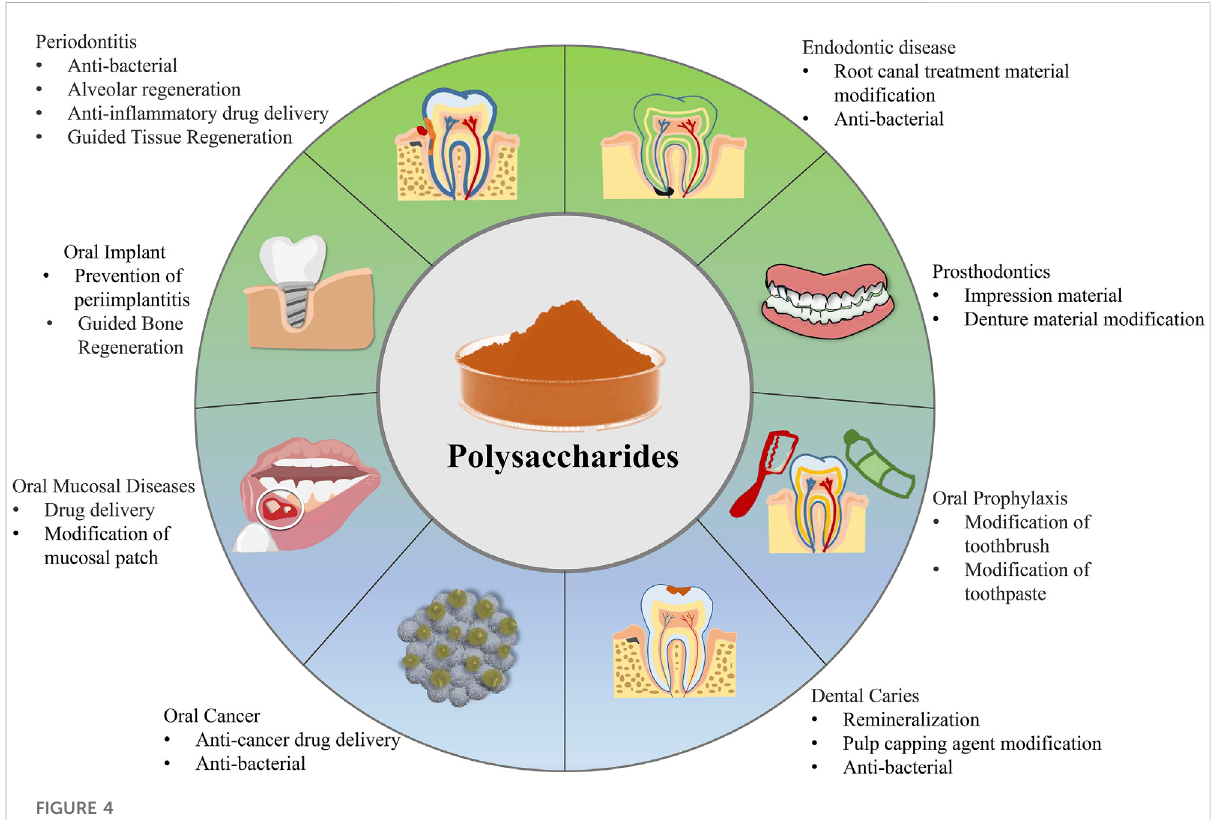
FIGURE 4 The applications of polysaccharides in